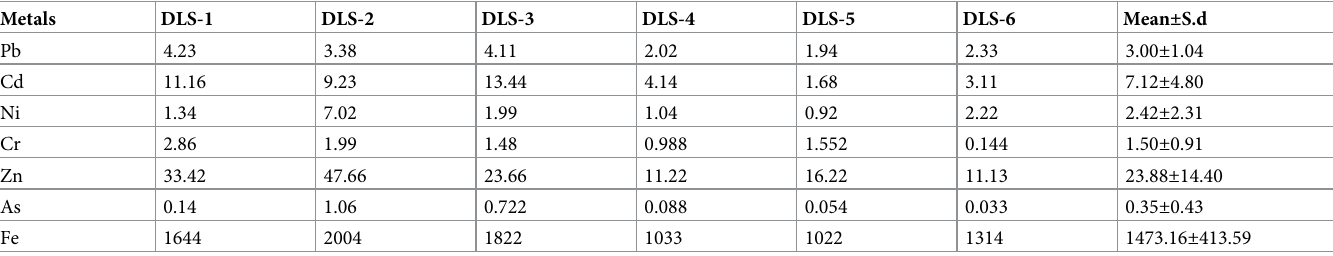
Table 1. Heavy metal concentrations (mg/L) in non-sanitary landfills